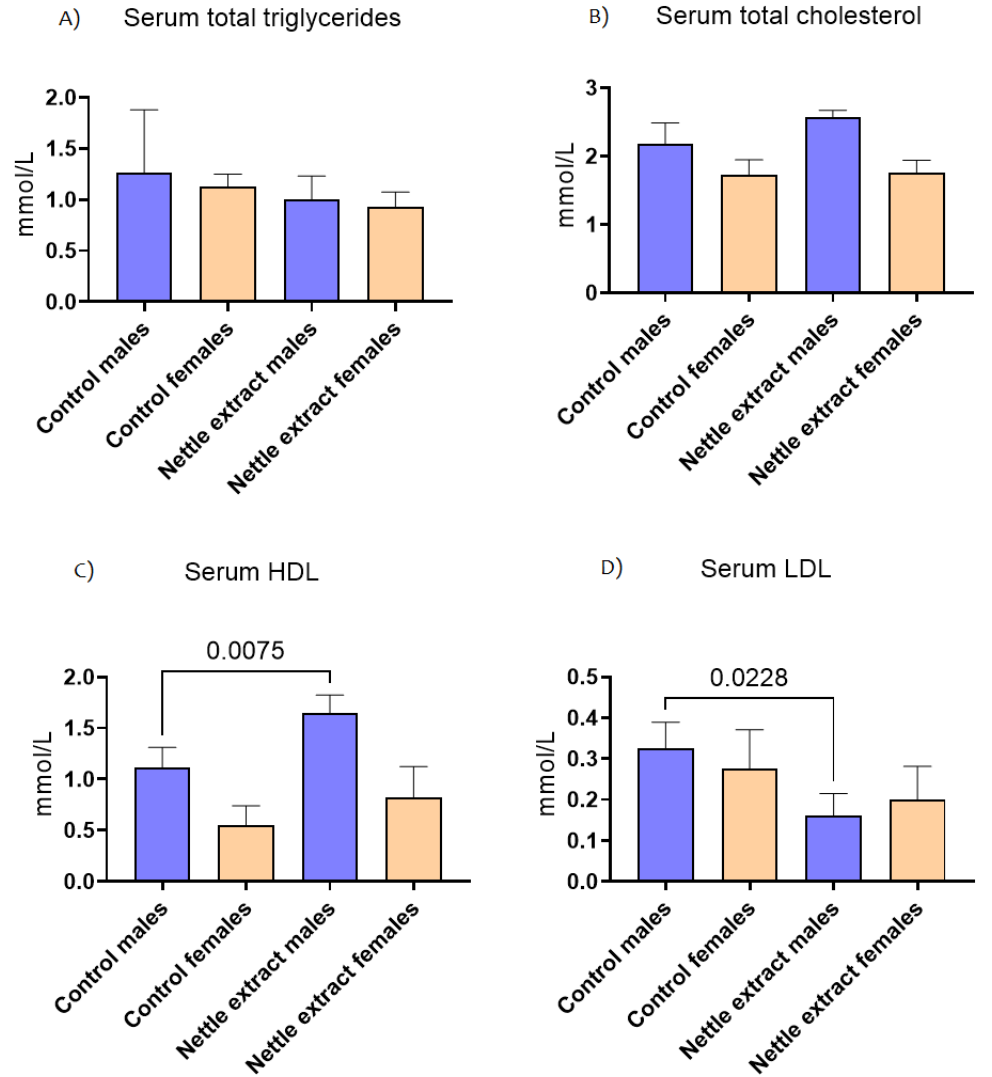
Figure 4. The changes in blood lipid level of C57Bl6 mice treated with nettle extract. The numbers above bars are p values meaning statistically significant ( p ≤ 0.05) differences between the treated groups by Kruskal – Wallis ANOVA.